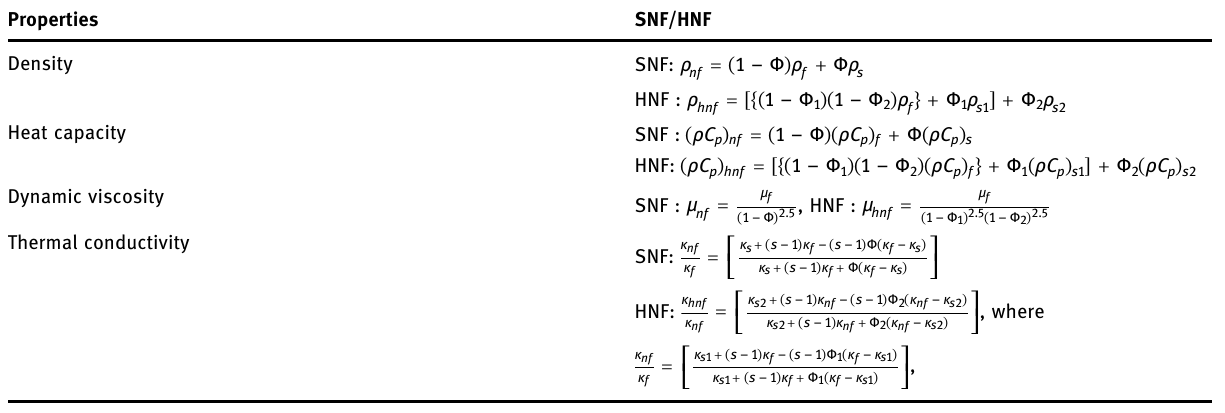
Table 1: The correlations of SNF and HNF [ 16, 53 ]